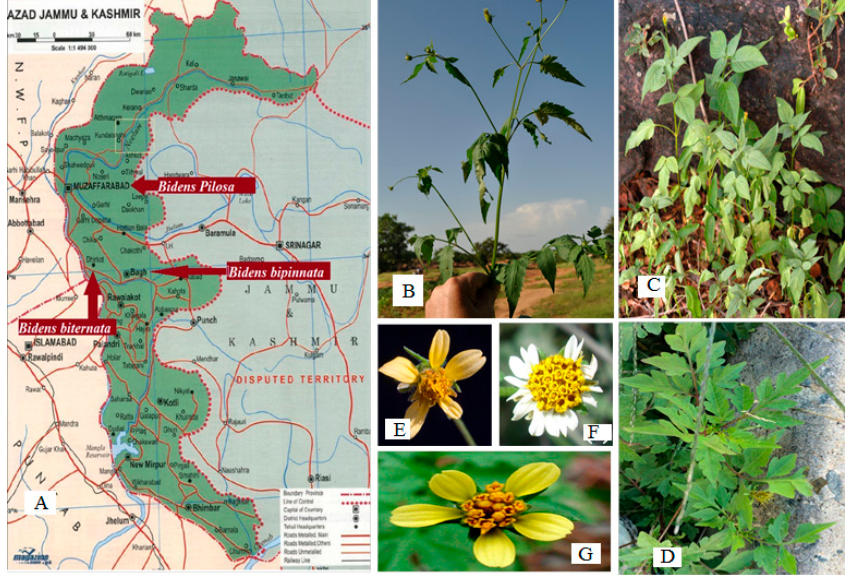
Figure 9. A : Collection areas of Plants; B : Bidens biternata ; C : Bidens Pilosa ; D : Bidens bipinnata ; E : Figure 9. ( A ): Collection areas of Plants; ( B ): Bidens biternata ; ( C ): Bidens Pilosa ; ( D ): Bidens bipinnata ; Bidens biternata flower; F : Bidens pilosa flower; G : Bidens bipinnata flower. ( E ): Bidens biternata flower; ( F ): Bidens pilosa flower; ( G ): Bidens bipinnata